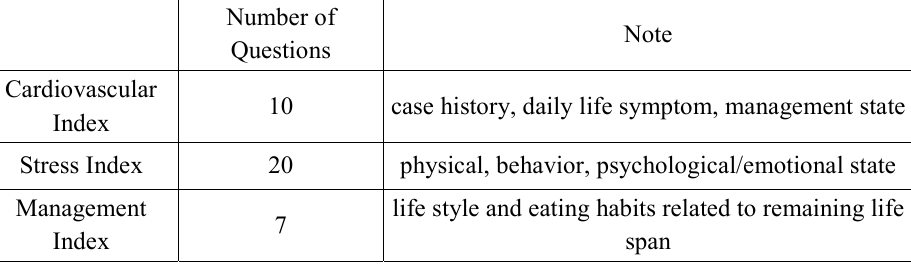
Table 2 Summary of questionnaire information for estimating health